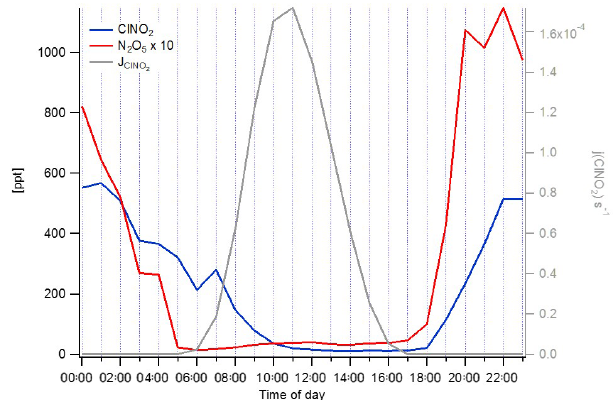
Figure 6. Diurnal profile of N 2 O 5 , ClNO 2 and j (ClNO 2 ) for the campaign highlighting the persistence of ClNO 2 past sunrise and the expected rapid photolysis of N 2 O 5 .